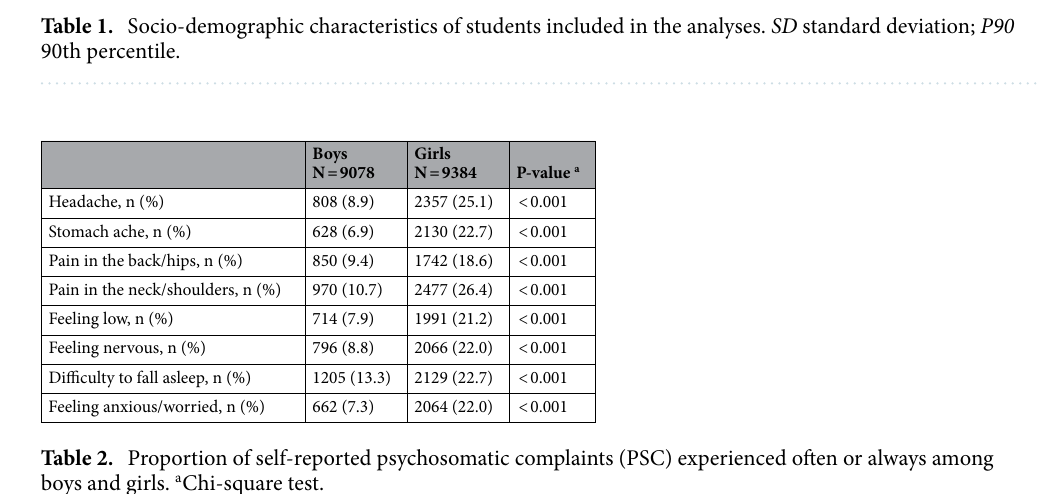
the results of multivariable binary logistic regression analyses between weight status and PSCs, and weight status and school-related complaints, respectively. Psychosomatic complaints associated with weight status.